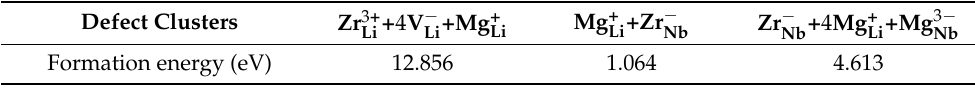
Table 1. Formation energies of defect clusters in LN:Mg,Zr. Defect